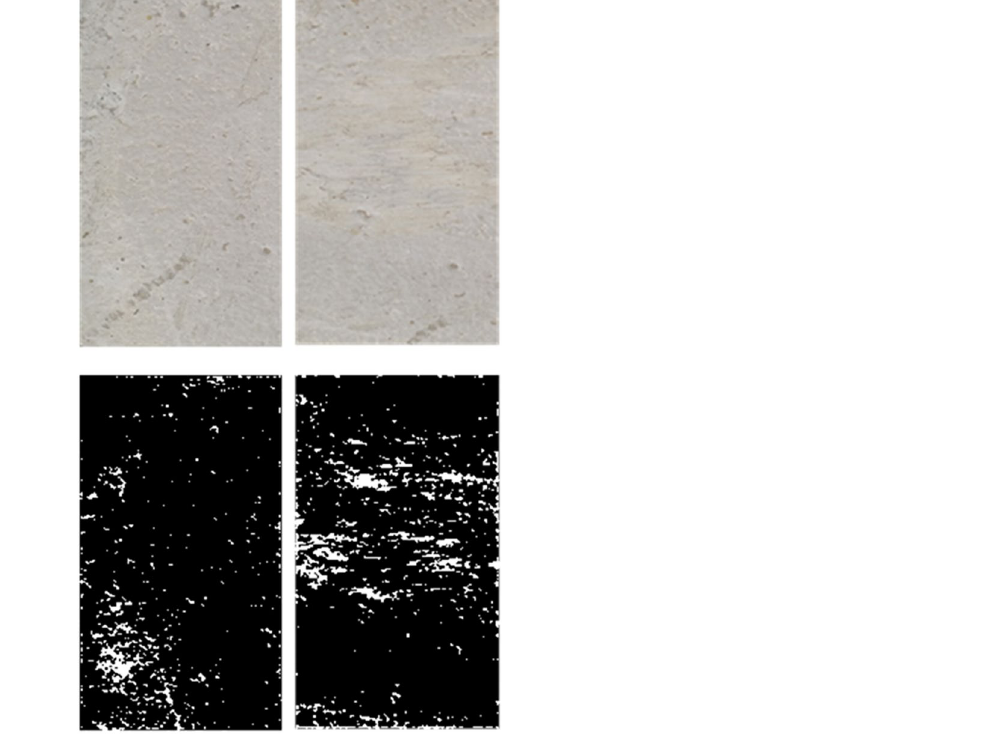
Figure 5. Smooth surface before and after